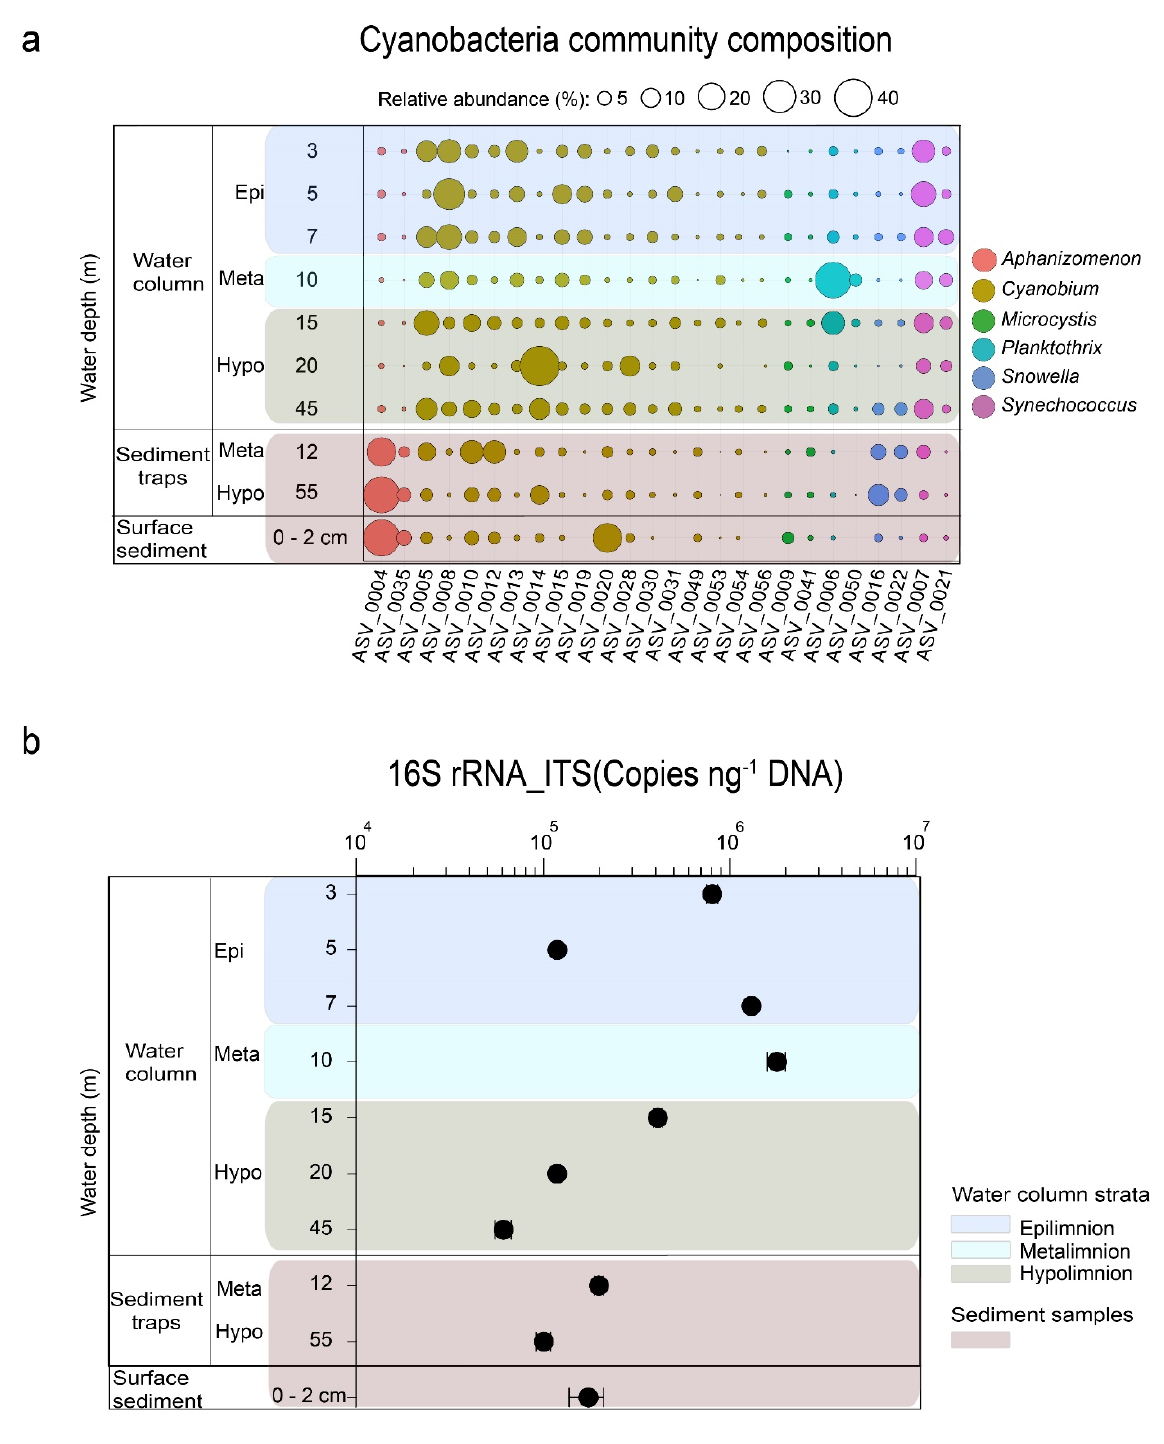
Figure 4. Cyanobacteria community composition and abundance in Lake Tiefer See water, trapped material, and sediments: ( a ) Bubble plot showing mean relative abundances for 2019 of the most abundant cyanobacteria amplicon sequence variants (>1% reads) in the water column, sediment traps and surface sediments, and ( b ) Mean cyanobacterial abundance for 2019 in the water column, sediment traps, and surface sediments quantified via qPCR with primers that amplified part of the 16S rRNA internal transcriber spacer (ITS) region of cyanobacteria (data were normalized to ng DNA extracted). Epi = epilimnion, meta = metalimnion, and hypo = hypolimnion.